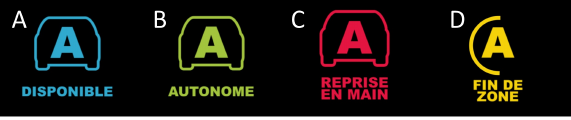
Figure 2: Pictograms displayed on the HMI. A: autonomous driving available; B: autonomous driving activated; C: